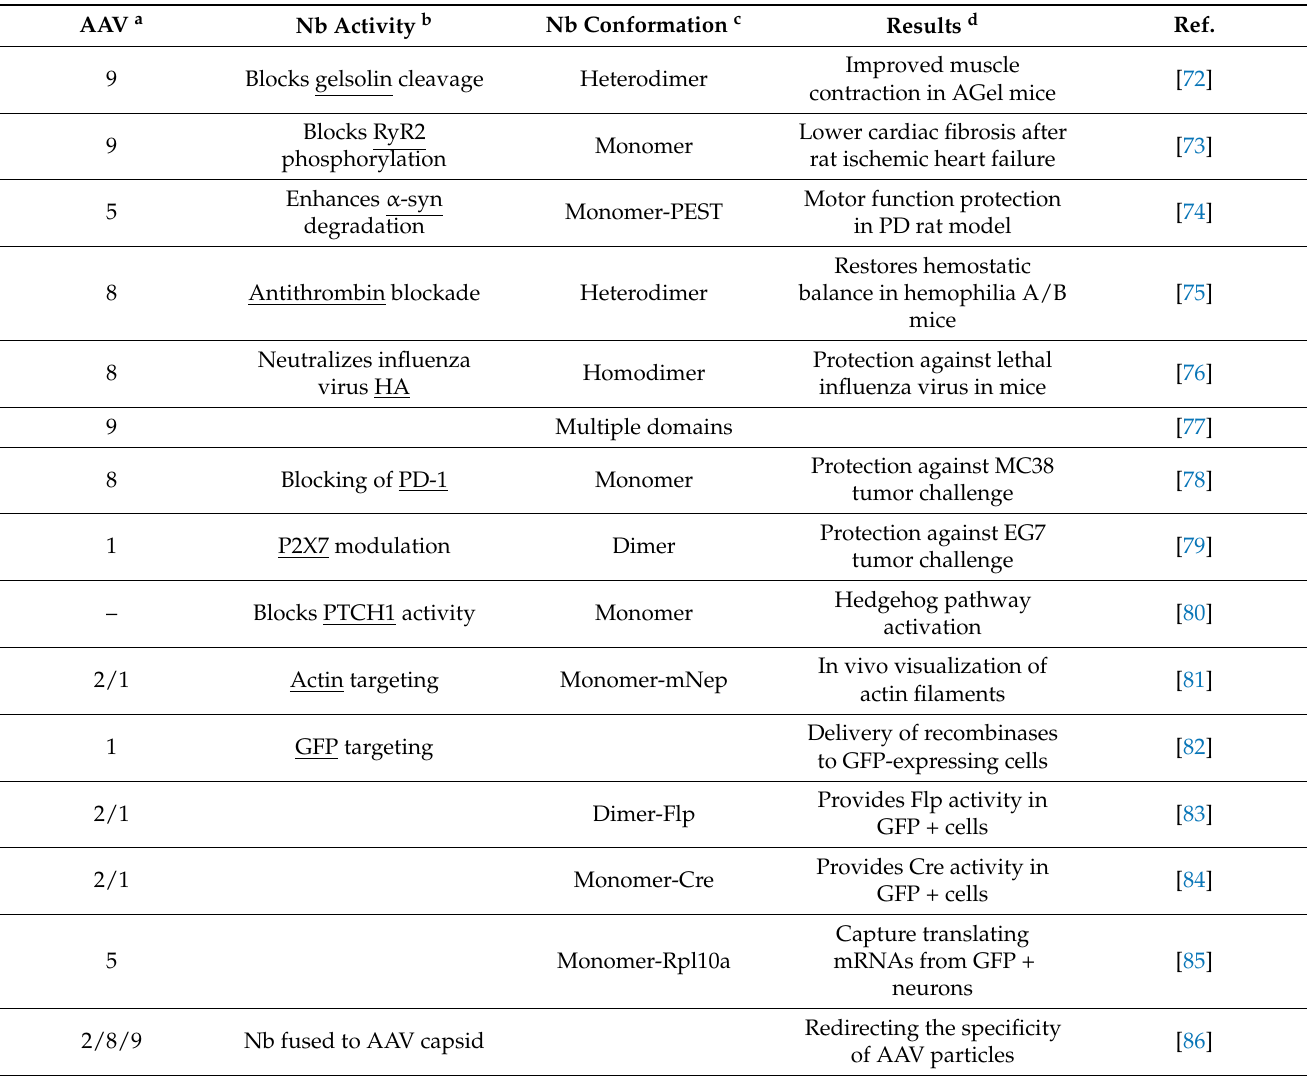
Table 2. AAVs to deliver